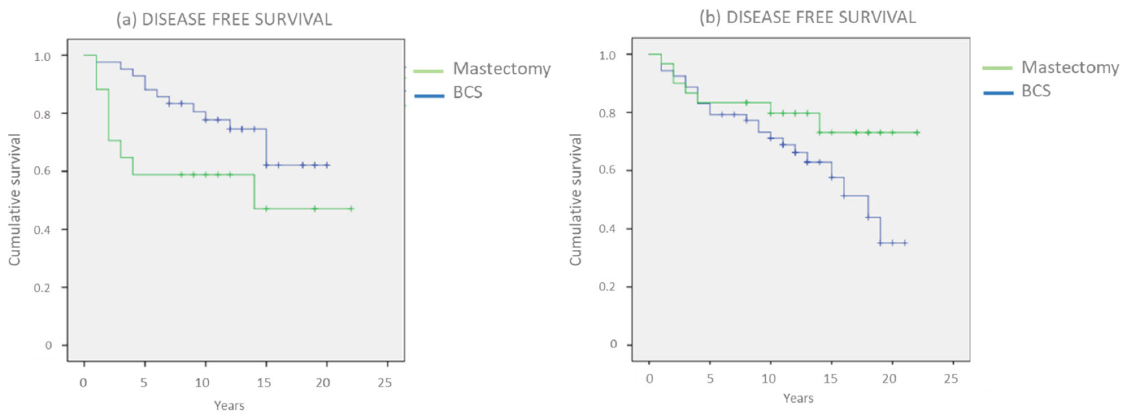
Figure 2. Disease-free survival curve for patients with Luminal B tumor type ( a ) or a tumor size between 20 mm and 50 mm ( b ) according to type of surgery received.